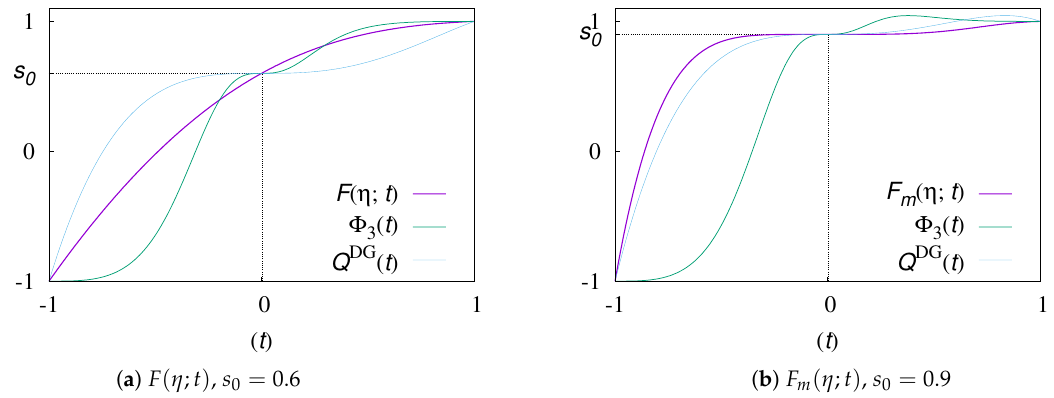
Figure 5. Graphs of the proposed rational transformation F ( η ; t ) , with η = 2 graphs of F m ( η ; t ) , with η = 1 and m chosen by (39), for s 0 = 0.9 in ( b ) compared with the composite 3 transformation Φ 3 ( t ) and the Doblaré-Gracia transformation Q DG ( t )